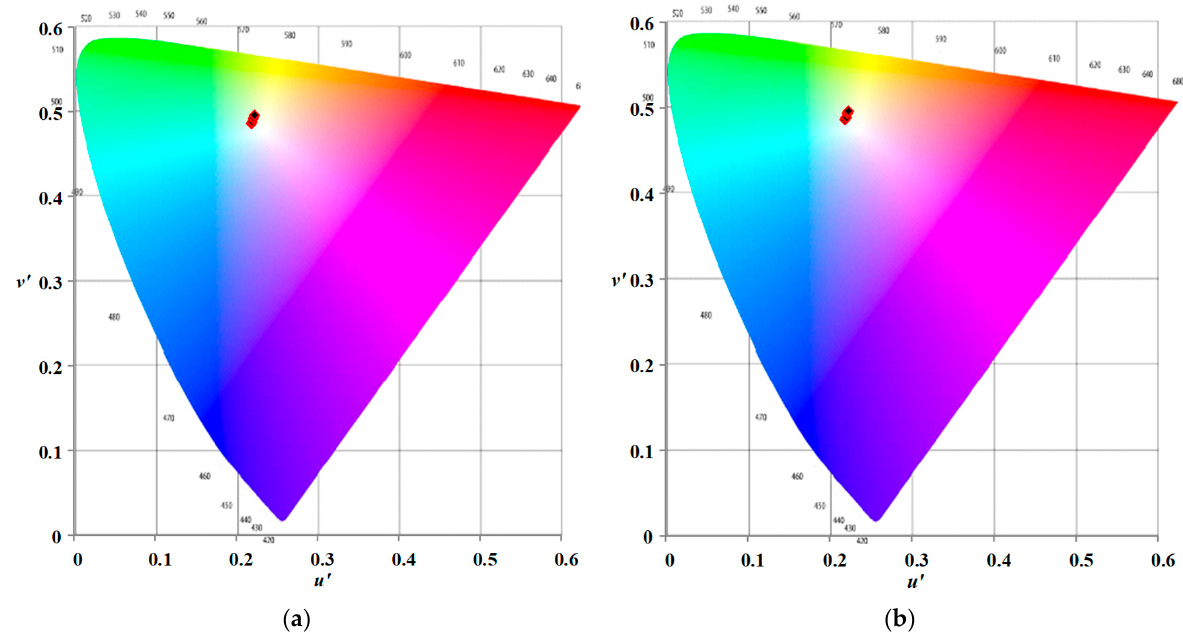
Figure 15. Measured CIE 1931 chromaticity diagrams with: ( a ) VCSR method; ( b ) VDSV method.